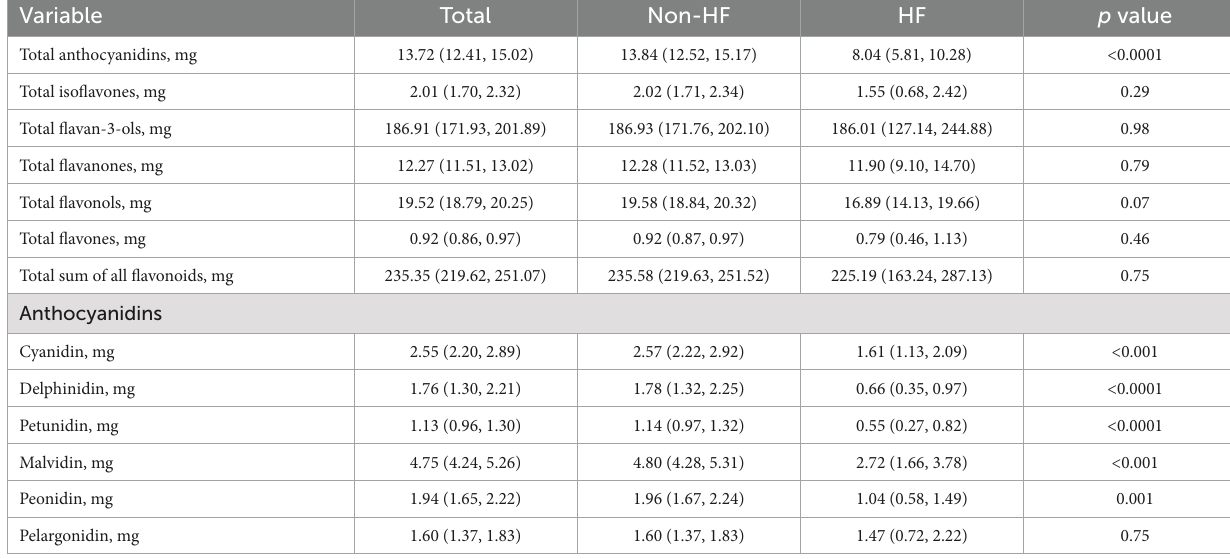
TABLE 2 Flavonoid in patients with or without heart failure.